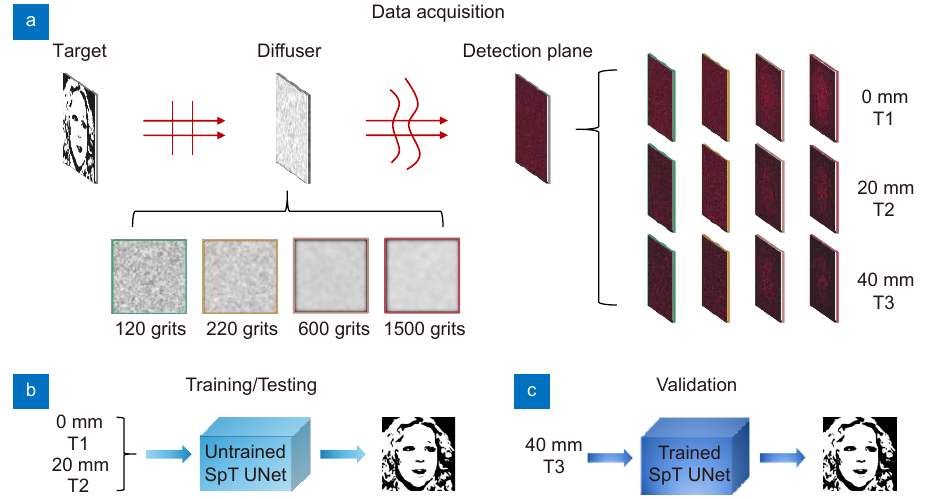
Fig. 5 | Overview of the data acquisition under various conditions and the training/testing/validation of the SpT UNet. ( a ) The training/testing data set is captured at T1 (0 mm), and T2 (20 mm). And the validation data set is captured at T3 (40 mm). The training/testing stage ( b ) and the validation stage ( c ) of the SpT UNet for the speckle reconstruction of the generic face